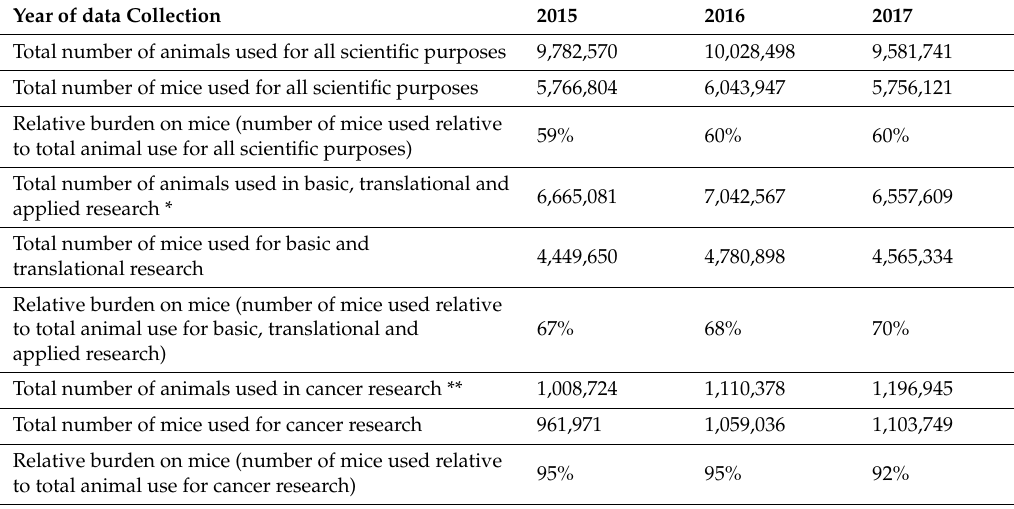
Table 4. The total number of animals used for scientific purposes throughout the European Union in 2015, 2016 and 2017, numbers of animals used in basic and translational / applied research and the numbers of animals used specifically in cancer research. Mice are the most commonly used species, and make up the majority of animals used for basic and translational / applied research and for cancer research. Data from